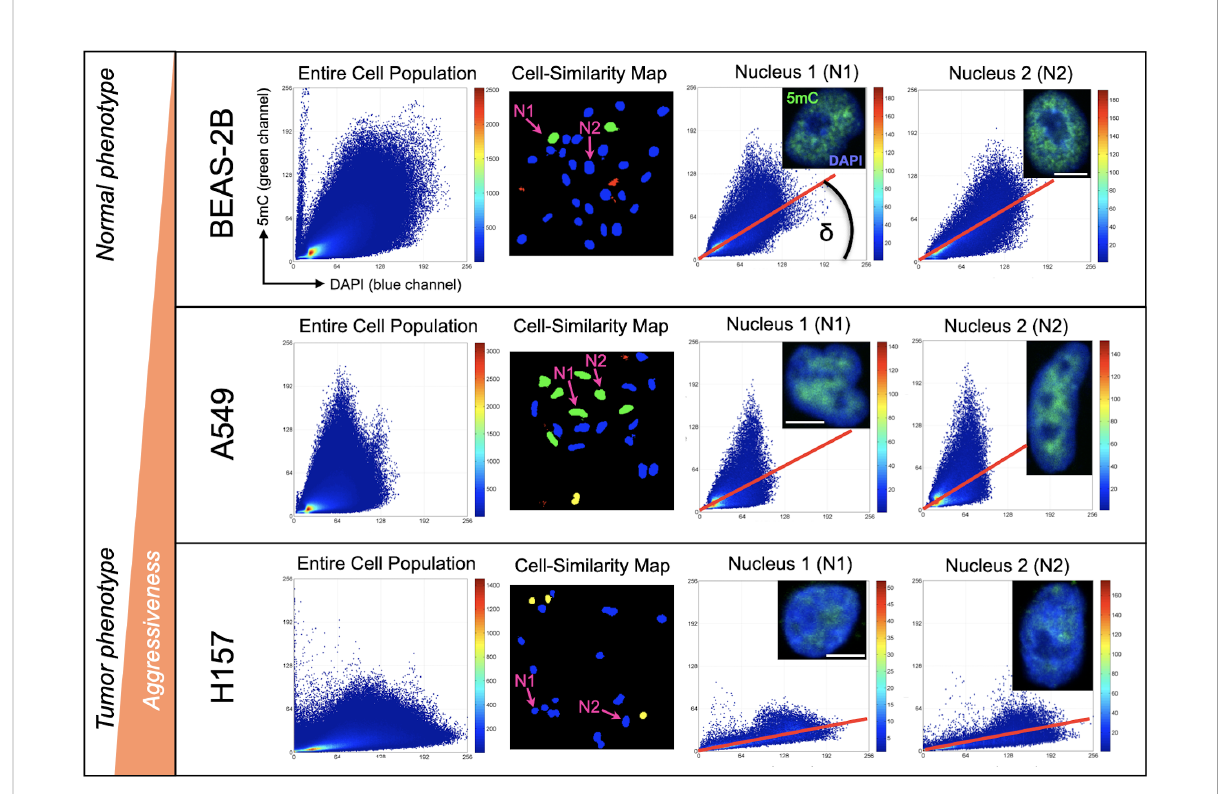
FIGURE 1 Global DNA methylation phenotyping of cultured cells with 3D-qDMI. The method was able to distinguish between the different cell types based on differential 5mC/DAPI distribution patterns calculated and displayed as individual heat map scatter plots (DAPI = x-axis, 5mC = y-axis). Plots were generated for the entire cell population (composite 5mC/DAPI codistribution of all measured cell nuclei) as the reference plot, and for each cell nucleus. Cell-similarity maps based on K-L divergence indicate a high degree of homogeneity in 5mC/DAPI topology for all three cell lines. This is due to most cells being similar (green nuclei) and likely similar (blue nuclei). Selected cell nuclei N1 and N2 for each cell line selected from the cell-similarity maps represent the most dominant 5mC topology for each cell line. The angle d under the regression line (false-colored red) equals the 5mC/DAPI colocalization index for each nucleus. White bars are 5